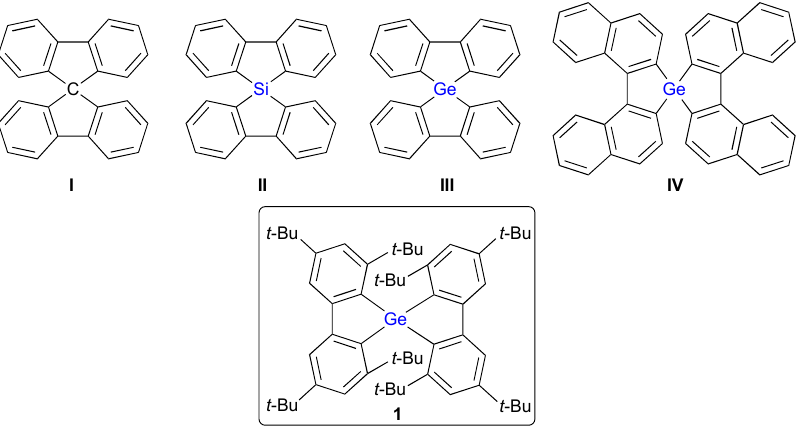
Figure 1. Spirobifluorene ( I ) and its Si- ( II ) and Ge-analogues ( III , IV and 1 ). Spirogermabifluorenes ( III ) are expected to exhibit even lower LUMO levels